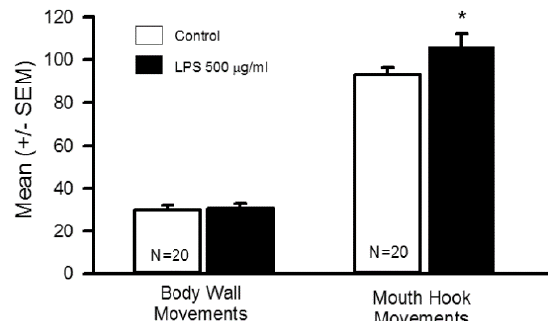
Figure 2. The results of the larval behavioral assays after consuming LPS for 48 h. The larvae mouth hook movements were significantly increased as compared to controls (N = 20, T-test p < 0.05).